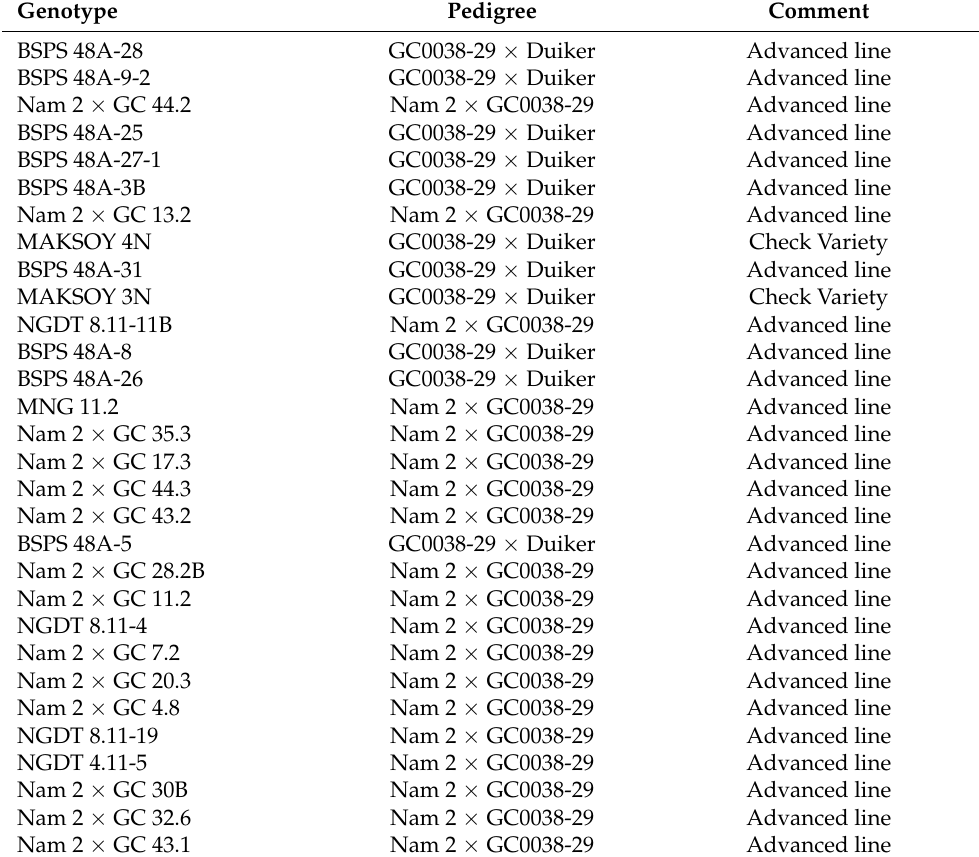
Table 1. Description of genotypes used in the